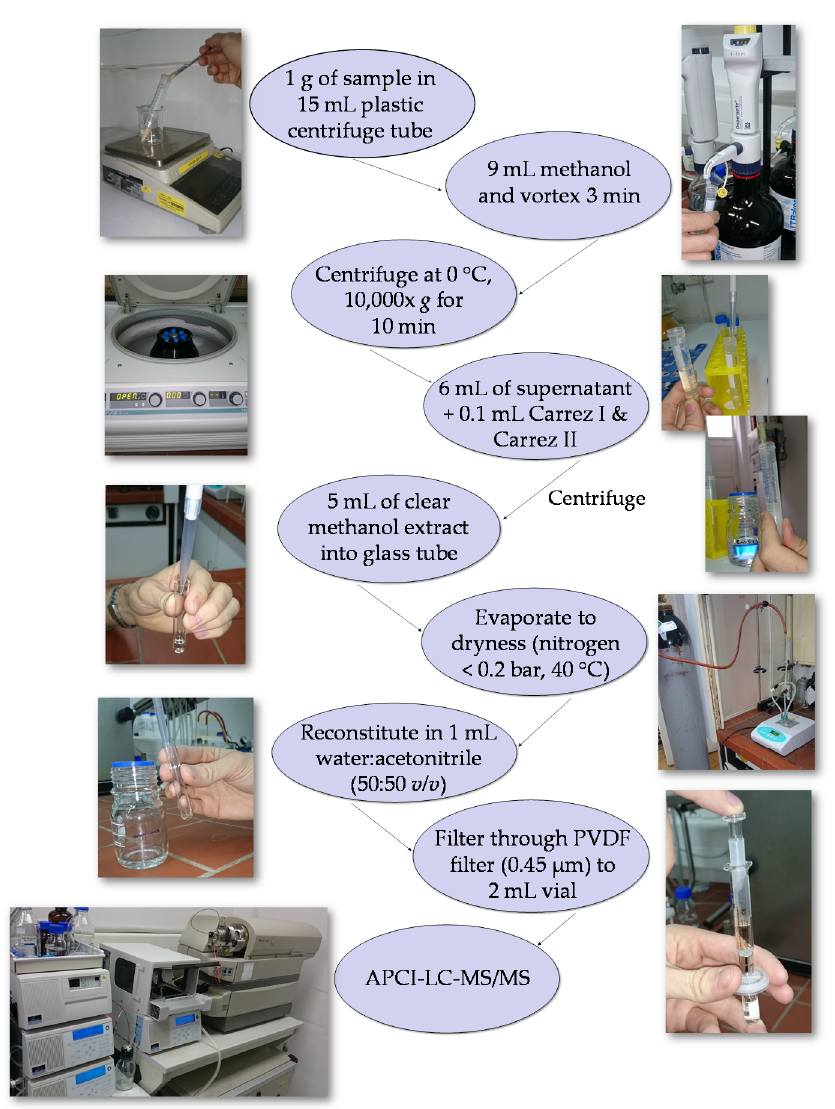
Figure 1. The liquid chromatography/tandem mass spectrometry (LC-MS/MS) method developed for the determination of acrylamide and hydroxymethylfurfural (HMF) in extruded and non-extruded corn-based samples.